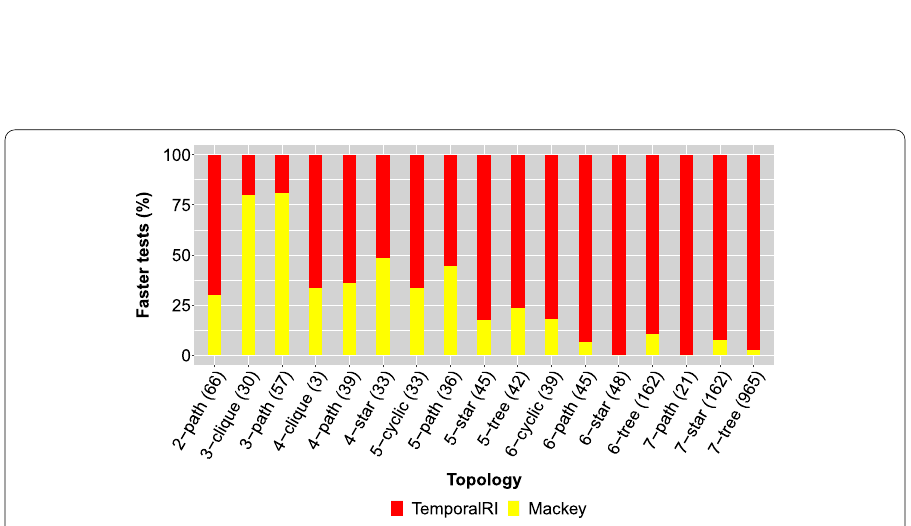
Fig. 9 Percentage of tests on queries with k = 6 edges in which TemporalRI or Mackey’s algorithm is the fastest. Results are clustered by subgraph topology. Number of tests in each cluster are indicated in parentheses. Experiments completed neither by TemporalRI nor by Mackey’s algorithm are excluded from the